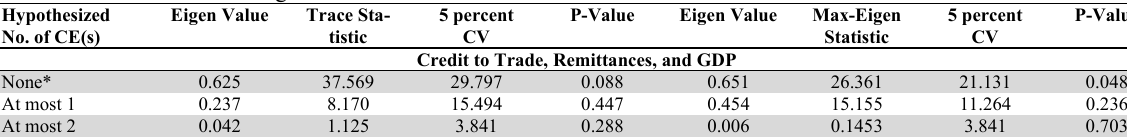
Johansen Multivariate Co-Integration Test Hypothesized No. of CE(s)